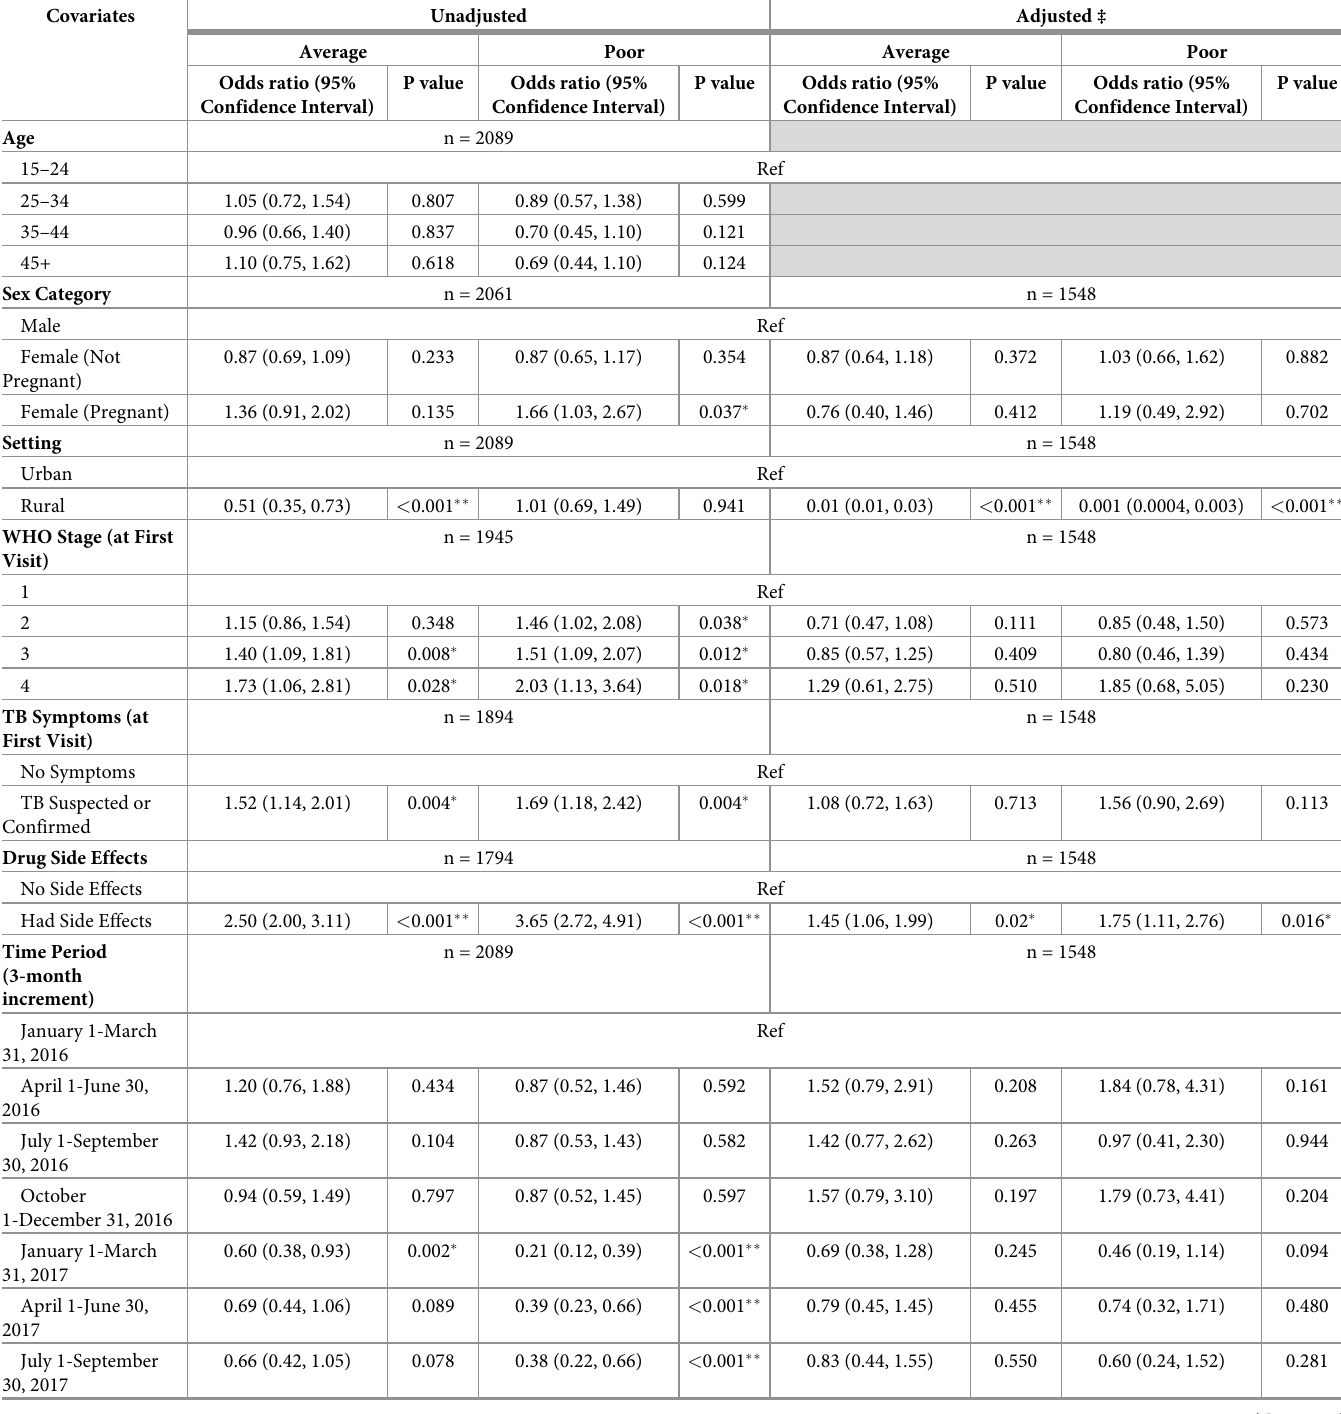
Table 4. Estimates of factors associated with suboptimal adherence among adolescents and adults in care and treatment. Covariates